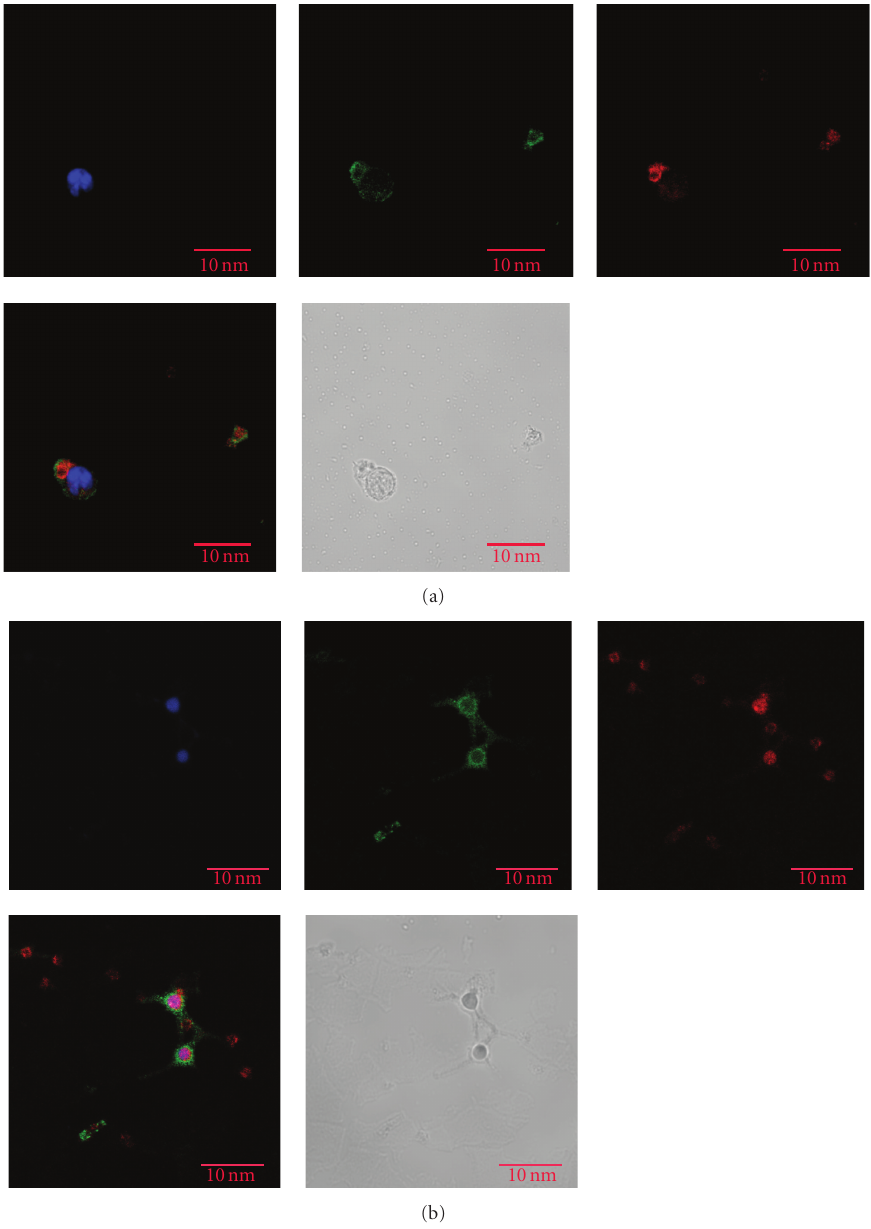
Figure 3: Dengue antigens on platelets and its derivative cells . Isolated platelets were stained with dengue-specific antibody (3H5) and platelets-specific markers (CD41). (a) Dengue antigen was observed in platelets and proplatelets. (b) Dengue antigen was observed in a micromegakaryocyte. Green: platelet marker CD41; Red: dengue antigen; and Blue; DAPI for nucleus staining. Red bar, 10 μ